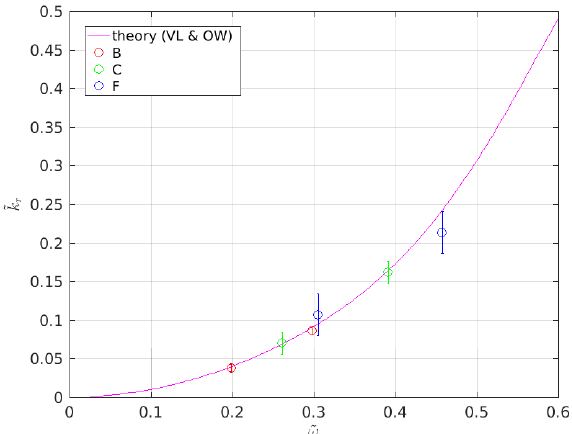
Figure 7. Non-dimensional wave number in ice (cid:101) k r versus wave frequency (cid:101) ω , normalized using (2) and (3). Average results from three test series are shown as circles with error bars. Also included are non-dimensionalized theoretical results for the viscous layer theory (using the same configuration as in Figure 6) and the open water theory. Both theoretical results follow the same curve. The viscous layer curve again used an effective viscosity of 0.02 m 2 /s.